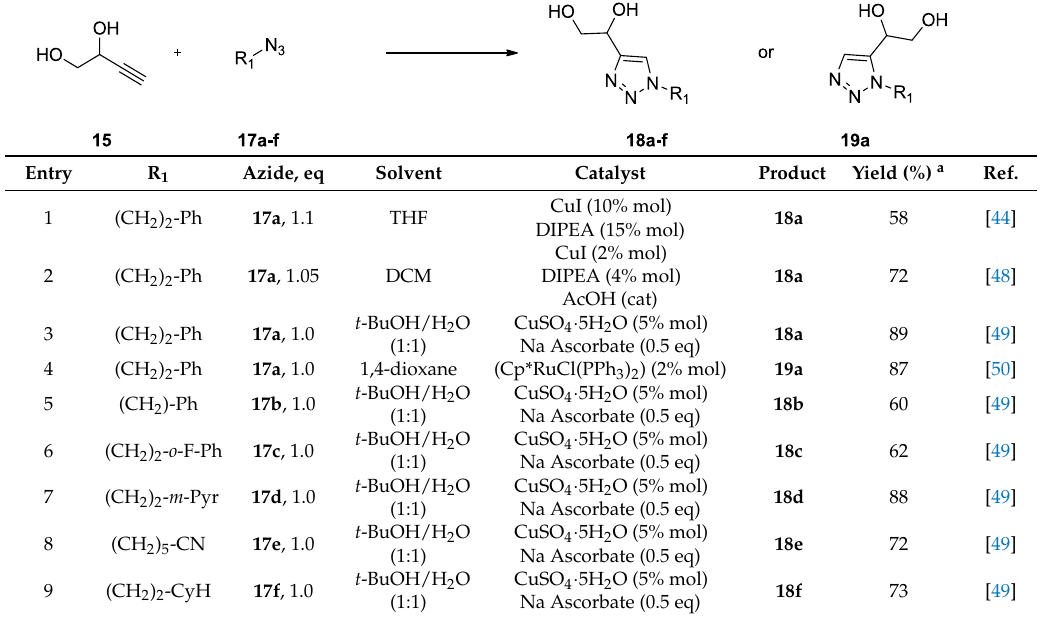
Table 2. The reaction conditions to obtain 18a – f and 19a . All reactions were performed overnight at room temperature except for entry 4 where the mixture was heated at 60 ◦ C.